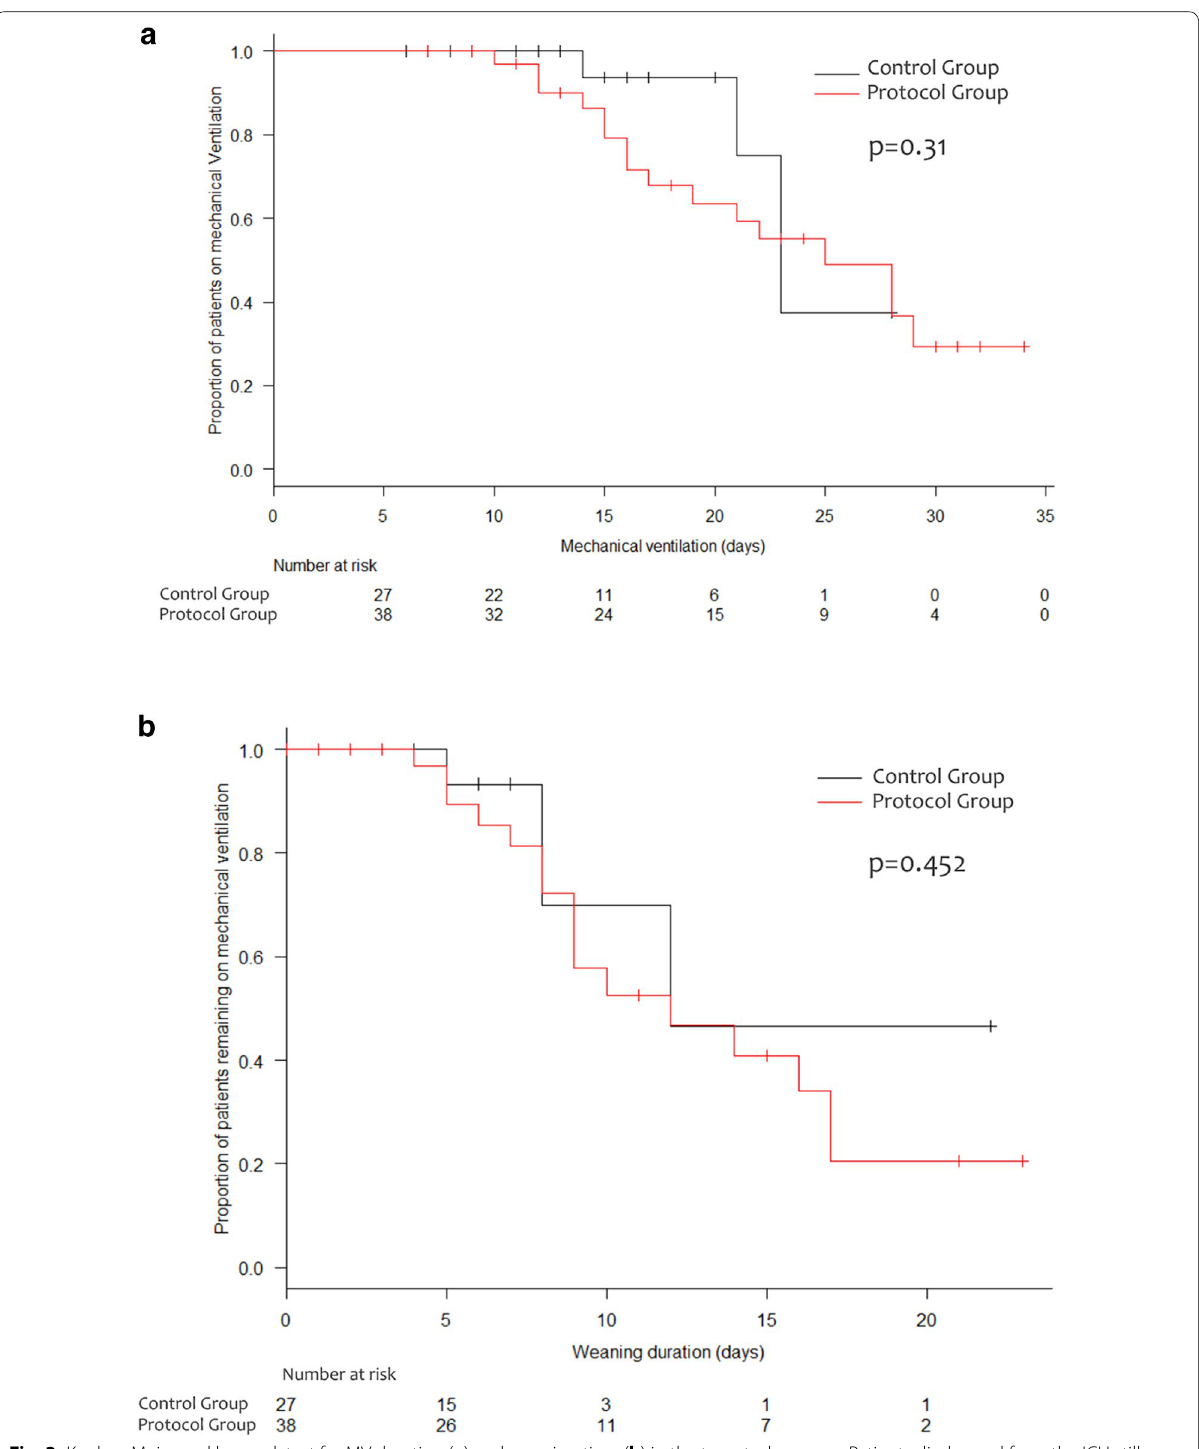
Fig. 3 Kaplan–Meier and log-rank test for MV duration ( a ) and weaning time ( b ) in the two study groups. Patients discharged from the ICU still ventilated or dead were